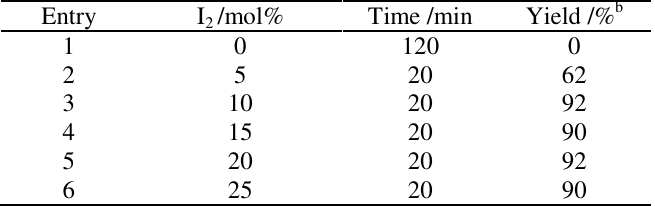
Table 1. The amounts of catalyst optimization for the synthesis of 4a